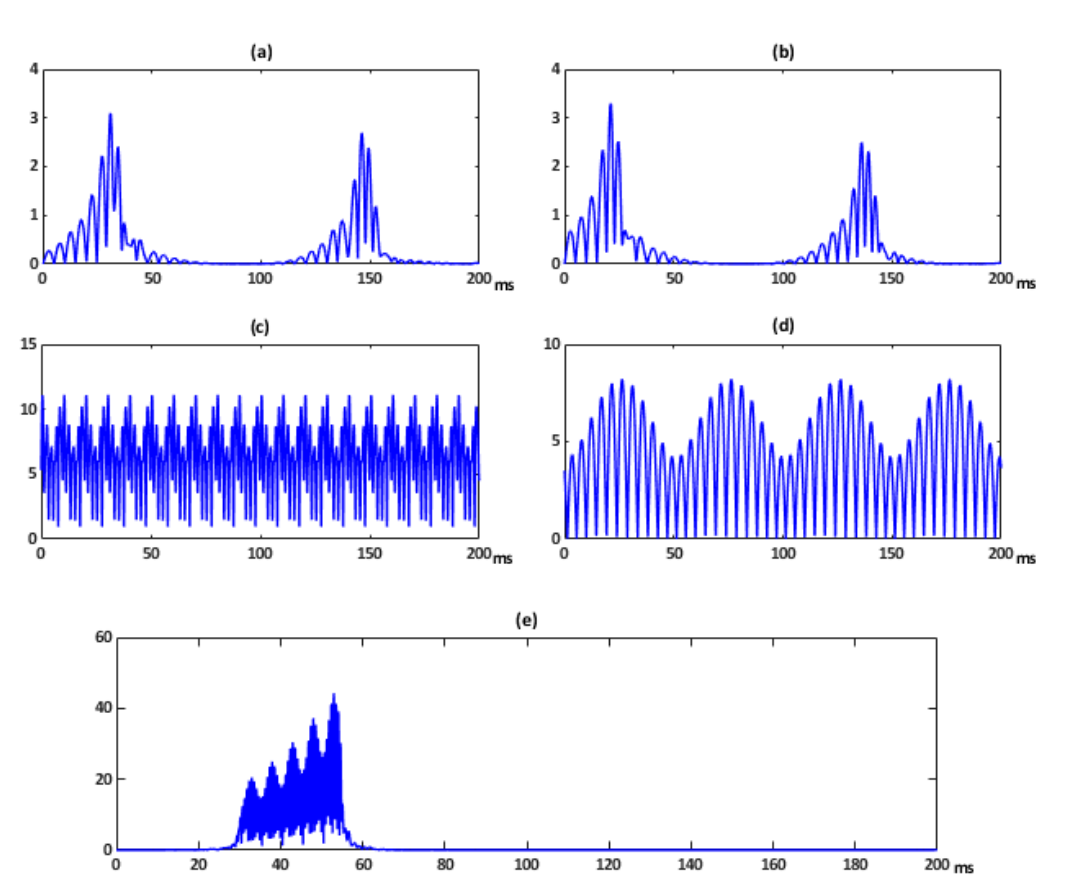
Figure 8. Instantaneous Transient Disturbance ratio index ITD ( t ) of voltage disturbances corresponding to Figure 5. Table 4. Summary of Power Quality Indices for the case A.